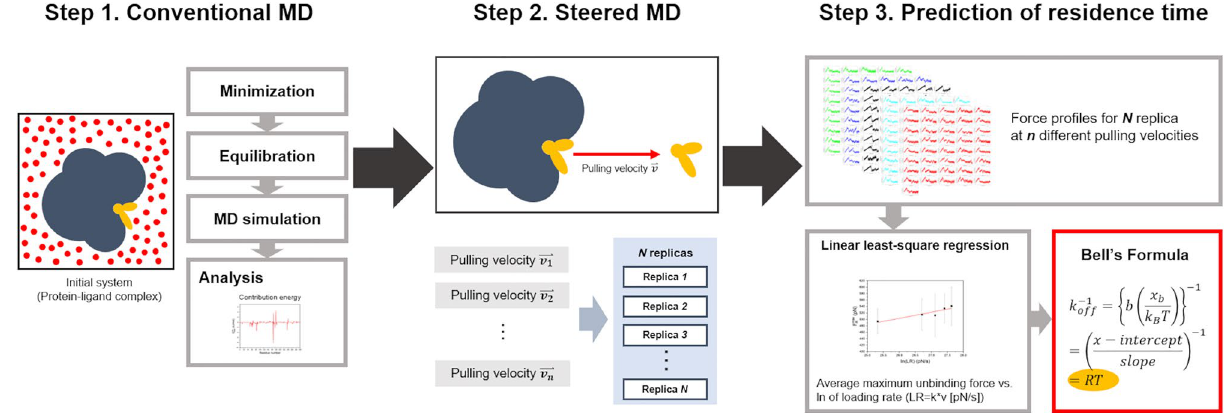
Figure 2. Workflow used in this work for the estimation of energetics and residence time (RT). In step 1, conventional molecular dynamics (MD) simulation was performed on the initial solvated system; subsequently energy calculations were performed on the simulated trajectory. In step 2, the final coordinate from the conventional MD simulation was subjected to steered molecular dynamics (SMD) simulations with different pulling velocities ( v ) and at a fixed spring force constant ( k ). At each of the pulling velocities SMD simulations were carried out in multiple replicas by reassigning the velocities on the starting structure. In step 3,